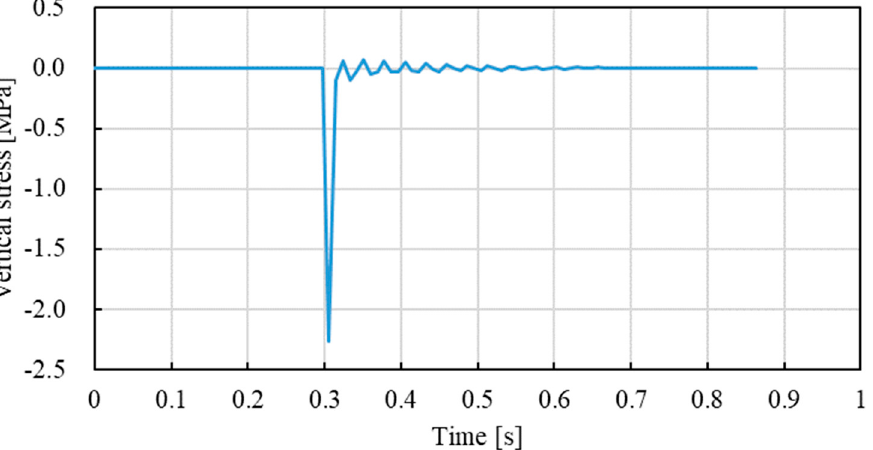
Figure 19. Marshall compaction-induced vertical stress obtained by finite element modelling with an asphalt mixture modulus of 40 MPa.